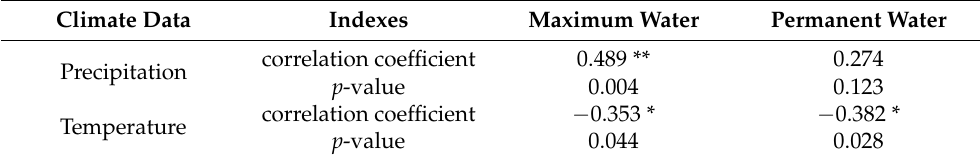
Table 5. Correlation analysis of the relationship between surface water and climate.